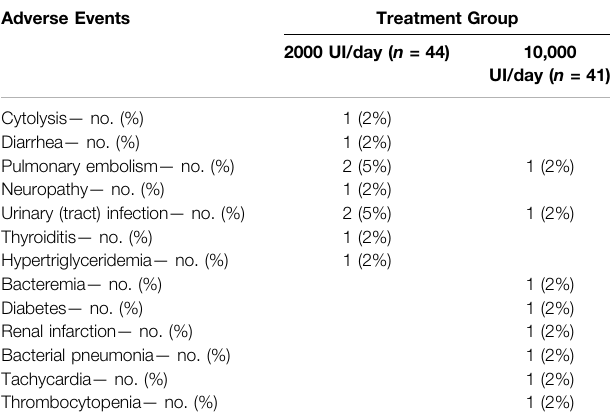
TABLE 7 | Adverse events in hospitalized patients with COVID-19 who received 2000 IU/day and 10,000IU/day of cholecalciferol. Adverse Events Treatment Group 2000 UI/day ( n = 44) 10,000 UI/day ( n = 41) Cytolysis — no.